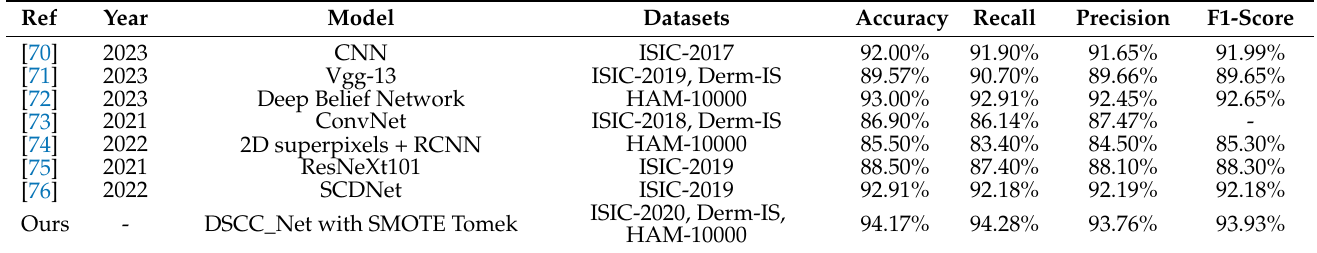
Table 6. Comparison of the DSCC_Net model with recent state-of-the-art studies.